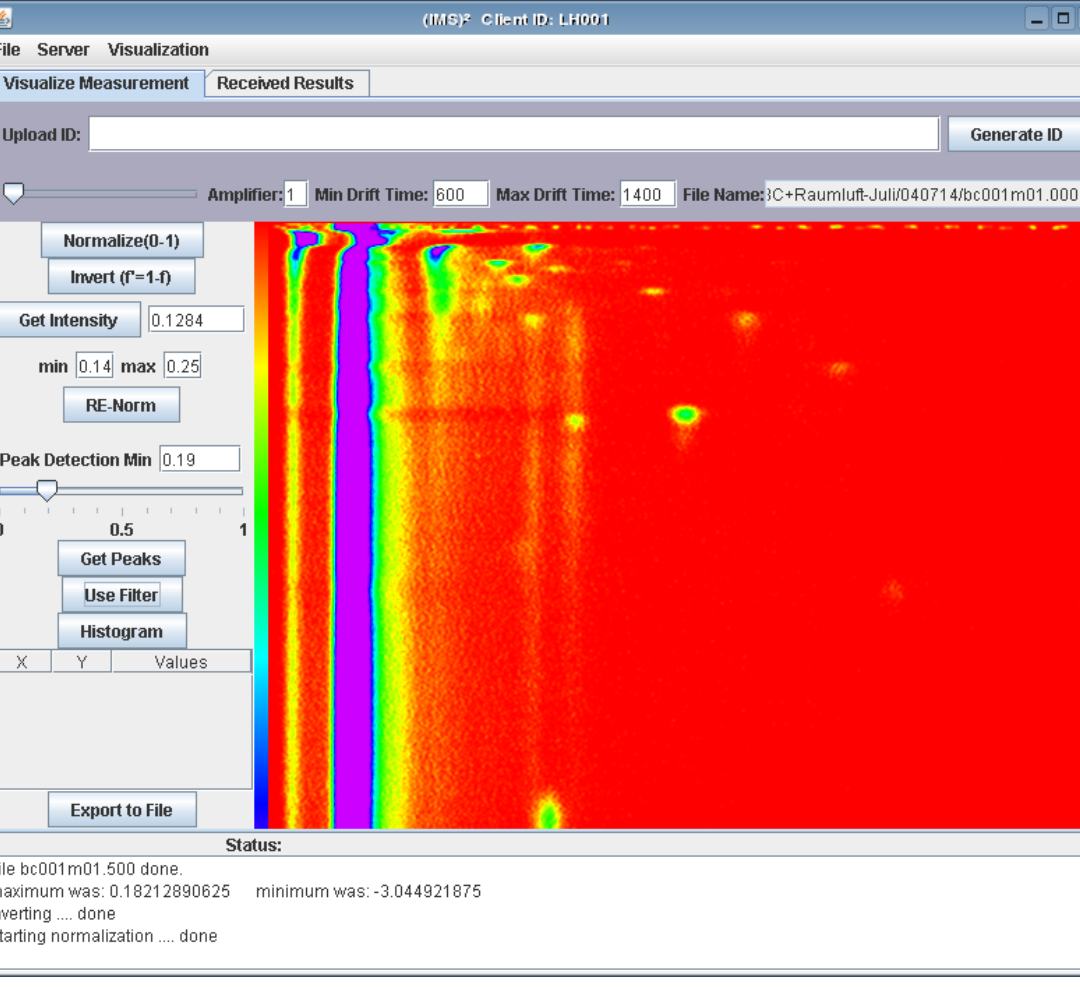
Figure 3: Screenshot of the IMS 2 client software with a sample lung cancer MCC/IMS result file visualized. The continuous band on the left side of the visualization is the so called RIP (Rest Ion Peak), which is present in every MCC/IMS